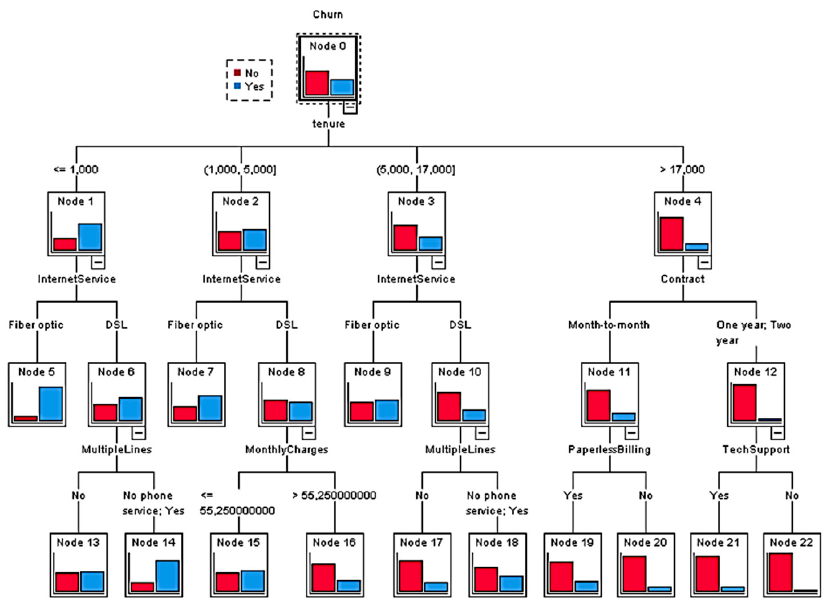
Figure 4. CHAID decision trees for Cluster 2. Source: authors’ work, 2021.